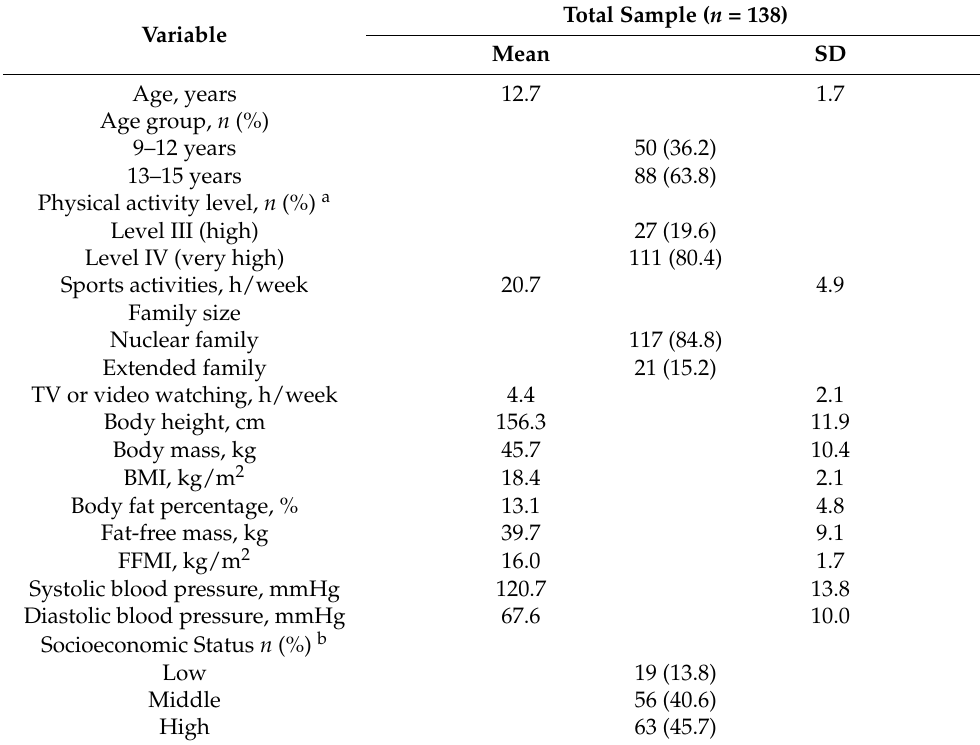
Table 1. Basic characteristics of the study participants.